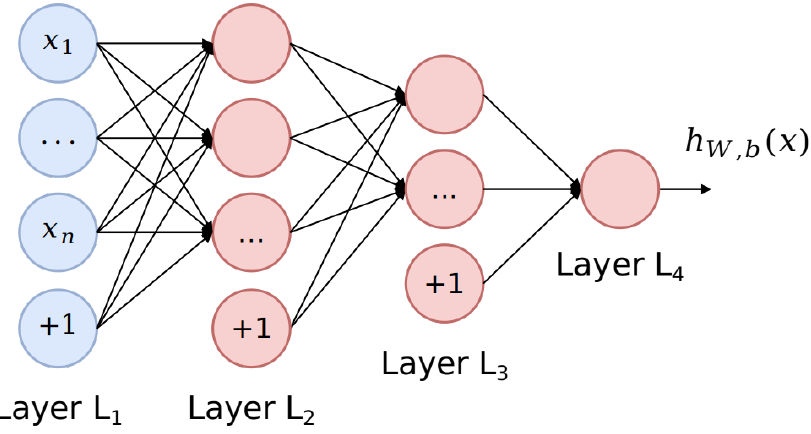
Figure 10. Architecture of the